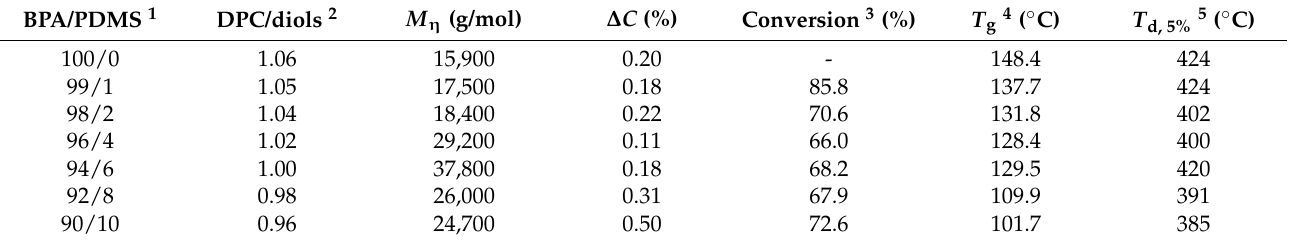
Table 4. Molecular-structure characteristics of silanol copolycarbonates with different feed ratios of BPA and Silanol 5.3 obtained from 1